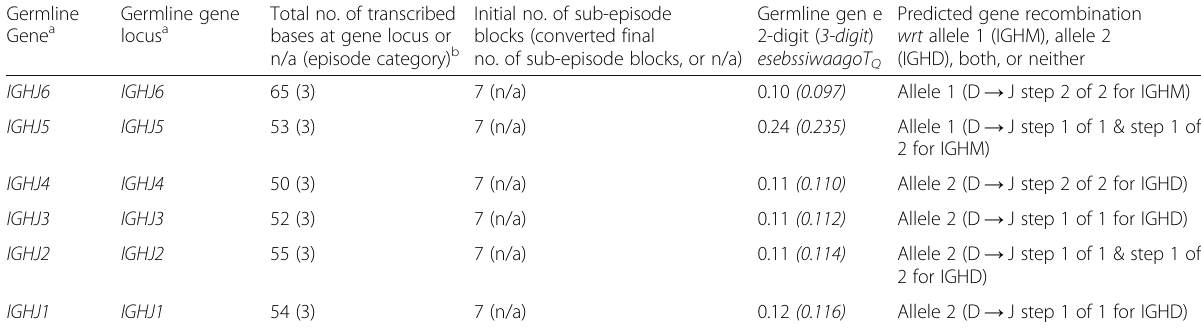
Table 2 Chromosome 14 ( − ) strand chromatin Ig heavy chain locus joining gene esebssiwaagoT Q s for germline genes in native 5 ′ - > 3 ′ chronology before gene